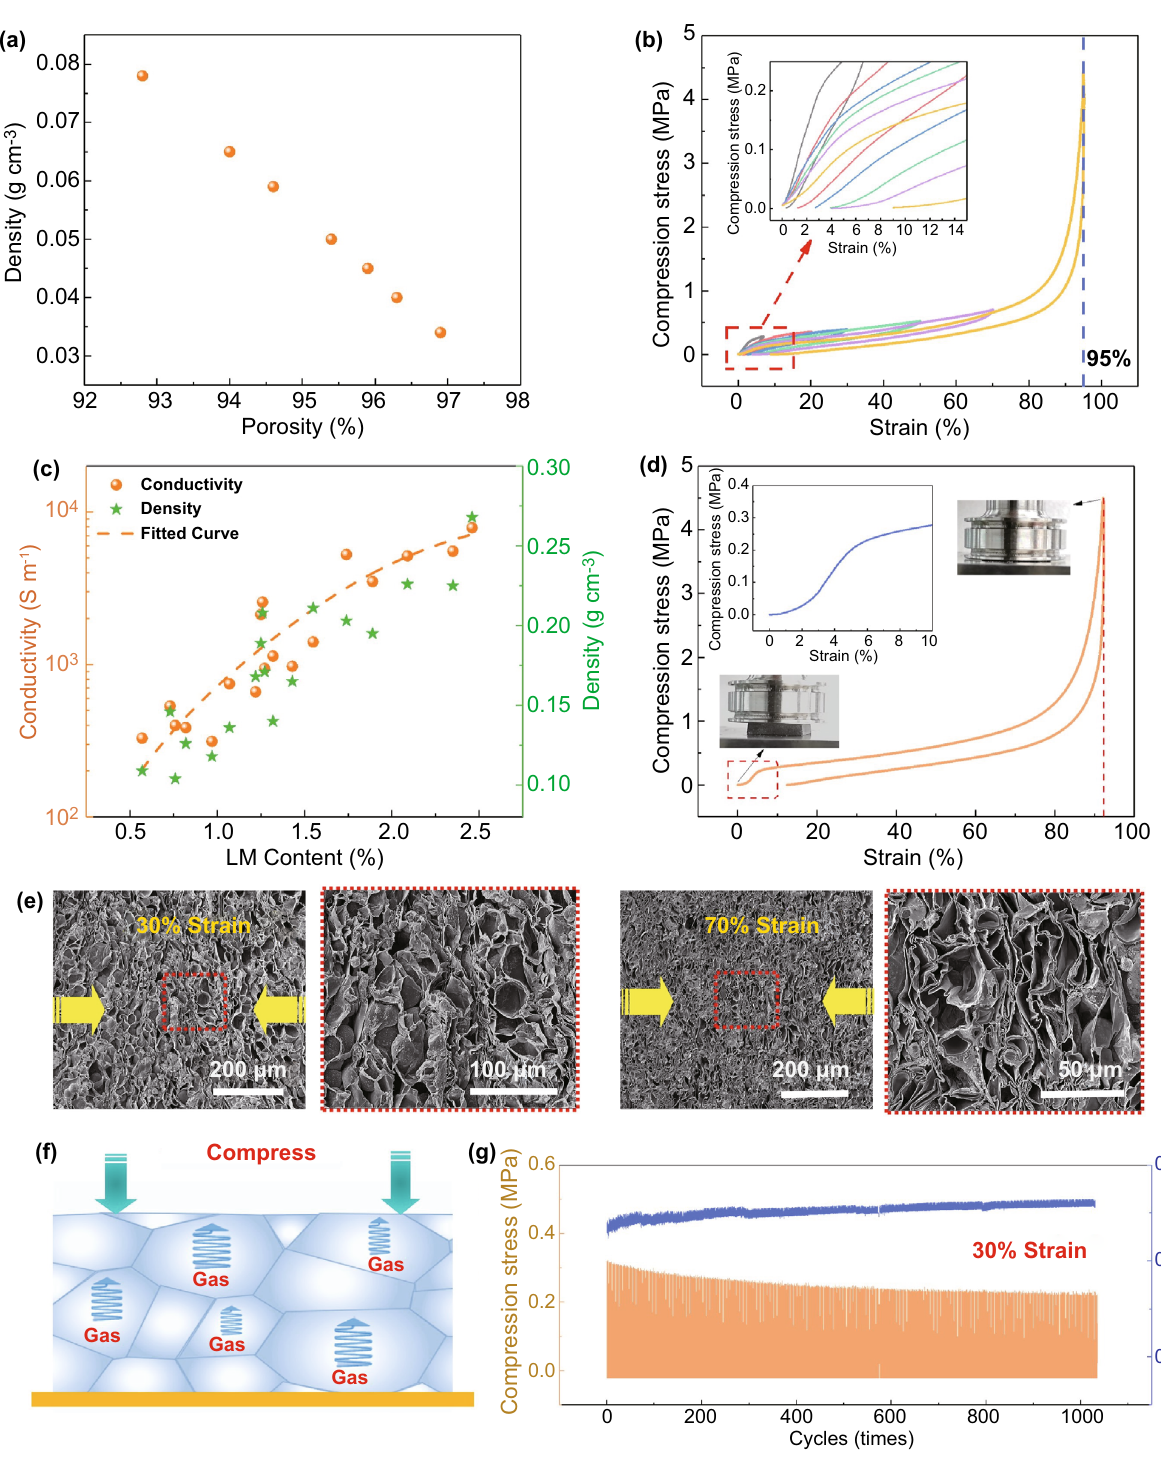
Fig. 3 Density, electrical and mechanical properties of the EMm and EM/LMm. a The density of EMm corresponding to porosity. b Compres‑ sion stress–strain curves of EMm (density: 0.054 g cm −3 ) under different strains. c The conductivity and density of EM/LMm depend on the LM content. d Compressive stress–strain curve of EM/LMm (density: 0.126 g cm −3 ) at 90% strain. e SEM images show deformation of cell structure at the compressive strain of 30% and 70%. f Schematic illustration dynamic elastic behaviors of the EM/LMm upon mechanical compression‑ releasing. g Mechanical–electrical properties of the EM/LMm under loading–unloading